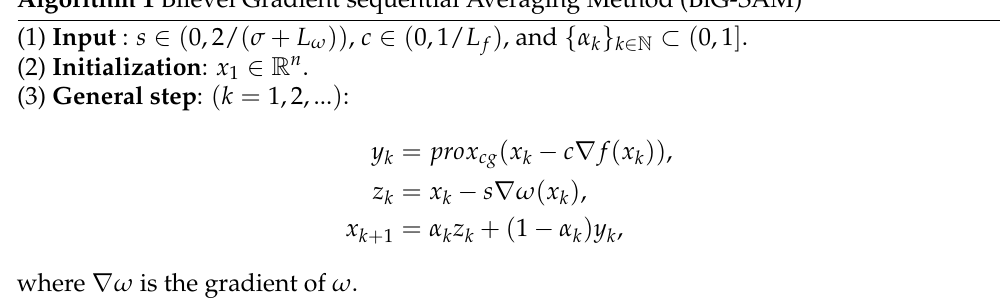
Algorithm 1 Bilevel Gradient sequential Averaging Method